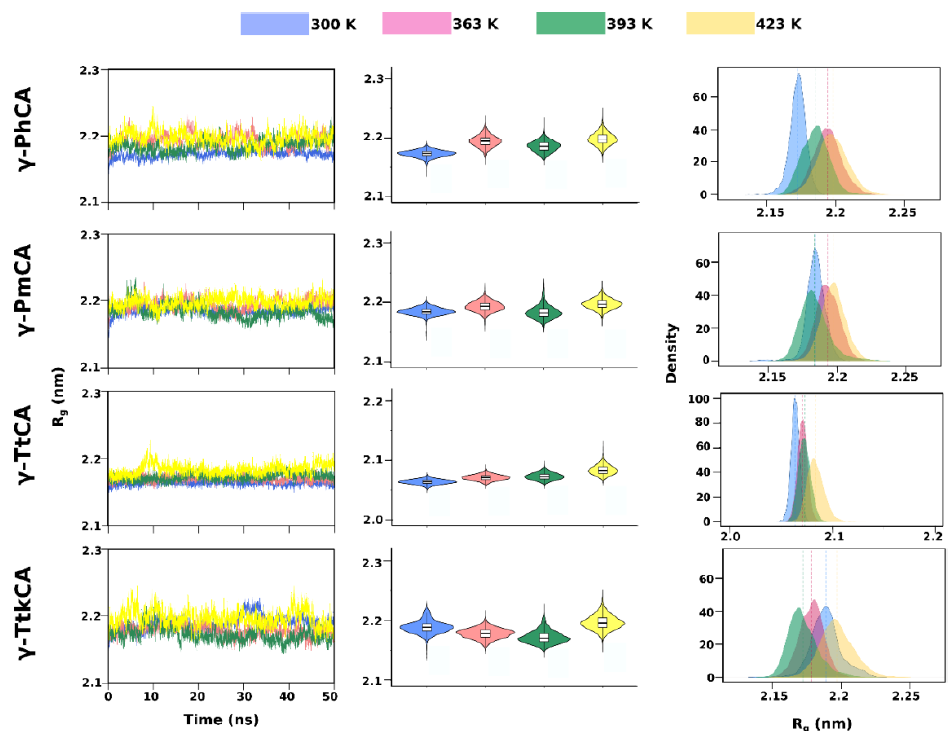
Figure 4. Radius of gyration (R g ) line graphs ( left ), violin plots ( middle ), and kernel density estimation (KDE) plots ( right ) of γ -PhCA, γ -PmCA, γ -TtCA and γ -TtkCA at 300 K, 363 K, 393 K and 423 K. Median values in the violin plots are shown by the black line in the white box plots and those in the KDE plots are shown as a line with a color corresponding to the respective plot color.